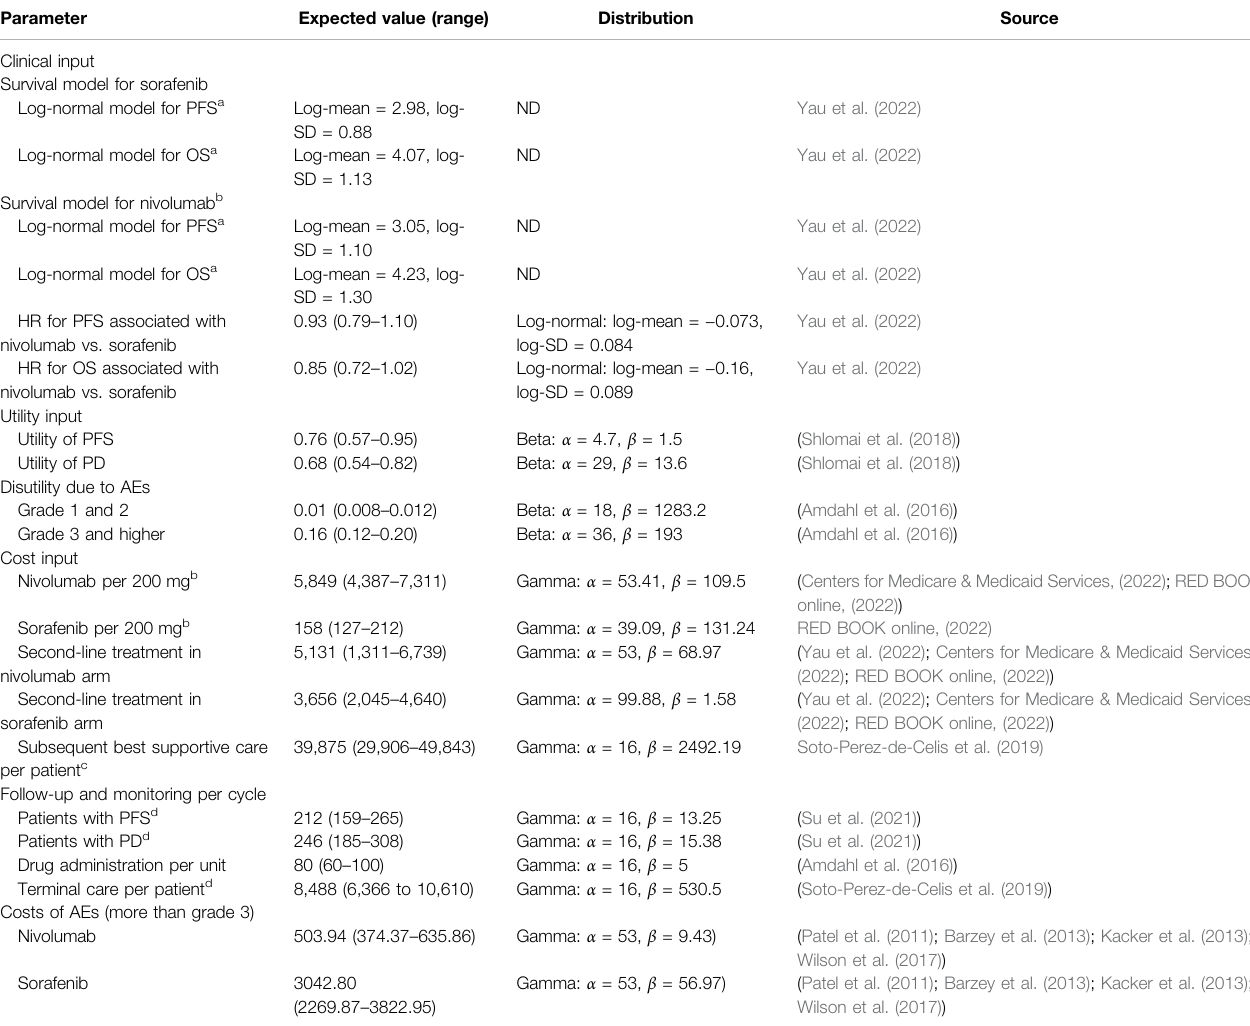
TABLE 1 | Key model